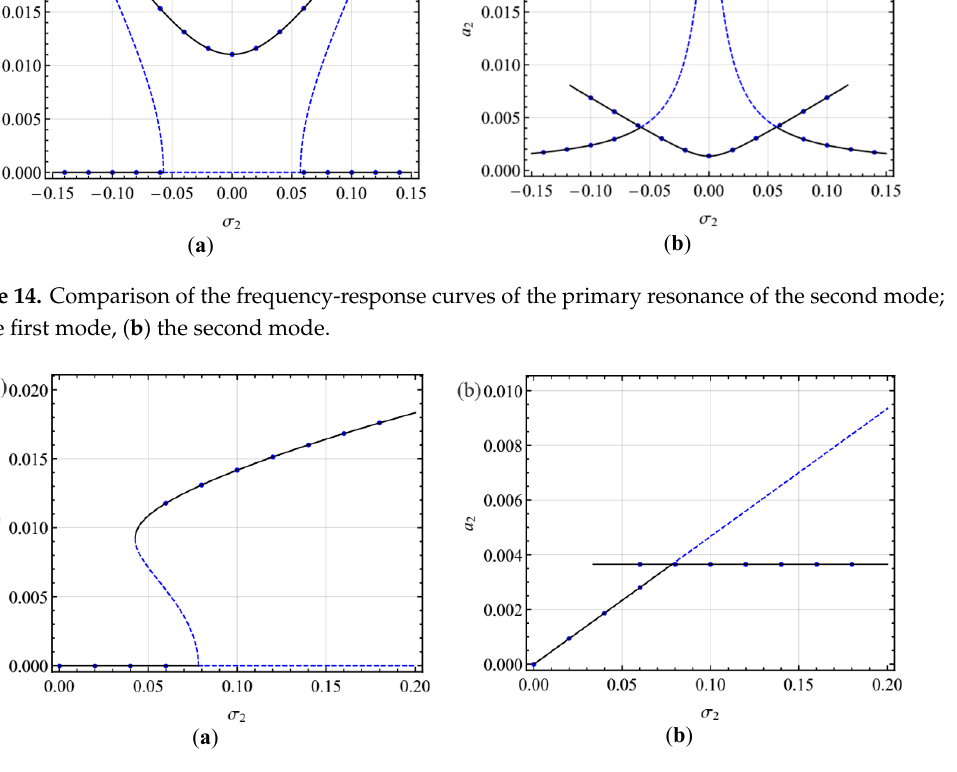
Figure 15. Comparison of the amplitude with forcing amplitude in the case of the primary resonance of the second mode; ( a ) the first mode, ( b ) the second mode.